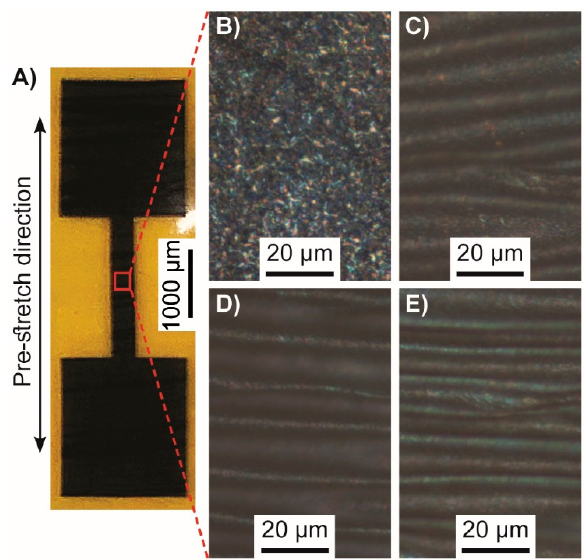
Figure 2. ( A ) Final device design with two contact pads joined by a 500 µm wide by 2000 µm long track. The device shown illustrates a laser structured PEDOT/TOS film on PDMS which was pre-stretched by 80%. The device is clear, however, here it was imaged on a Kapton substrate, giving it a yellow color. The close-up images show the structure of PEDOT/TOS on PDMS which had: ( B ) 0% pre-stretch; ( C ) 40% pre-stretch; ( D ) 60% pre-stretch; and ( E ) 80% pre-stretch. Clear buckled structures can be seen in PEDOT/TOS films which were placed onto pre-stretched PDMS that was then allowed to relax.